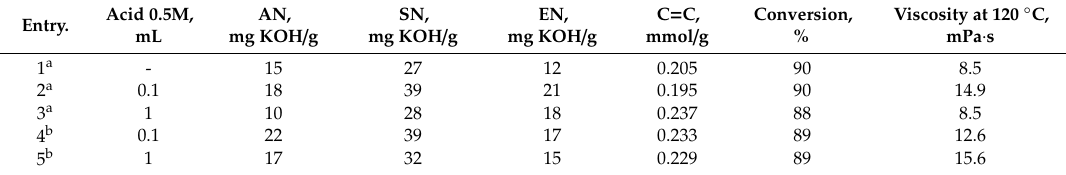
Table 3. E ff ect of H 2 SO 4 or H 3 PO 4 on the C30 + olefins oxidation using H 2 O 2 .